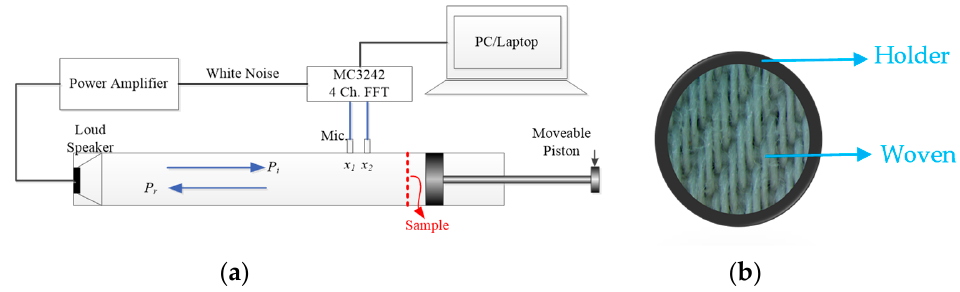
Figure 6. The schematic of measurement setup: ( a ) impedance tube ( b ) holder and woven sample .